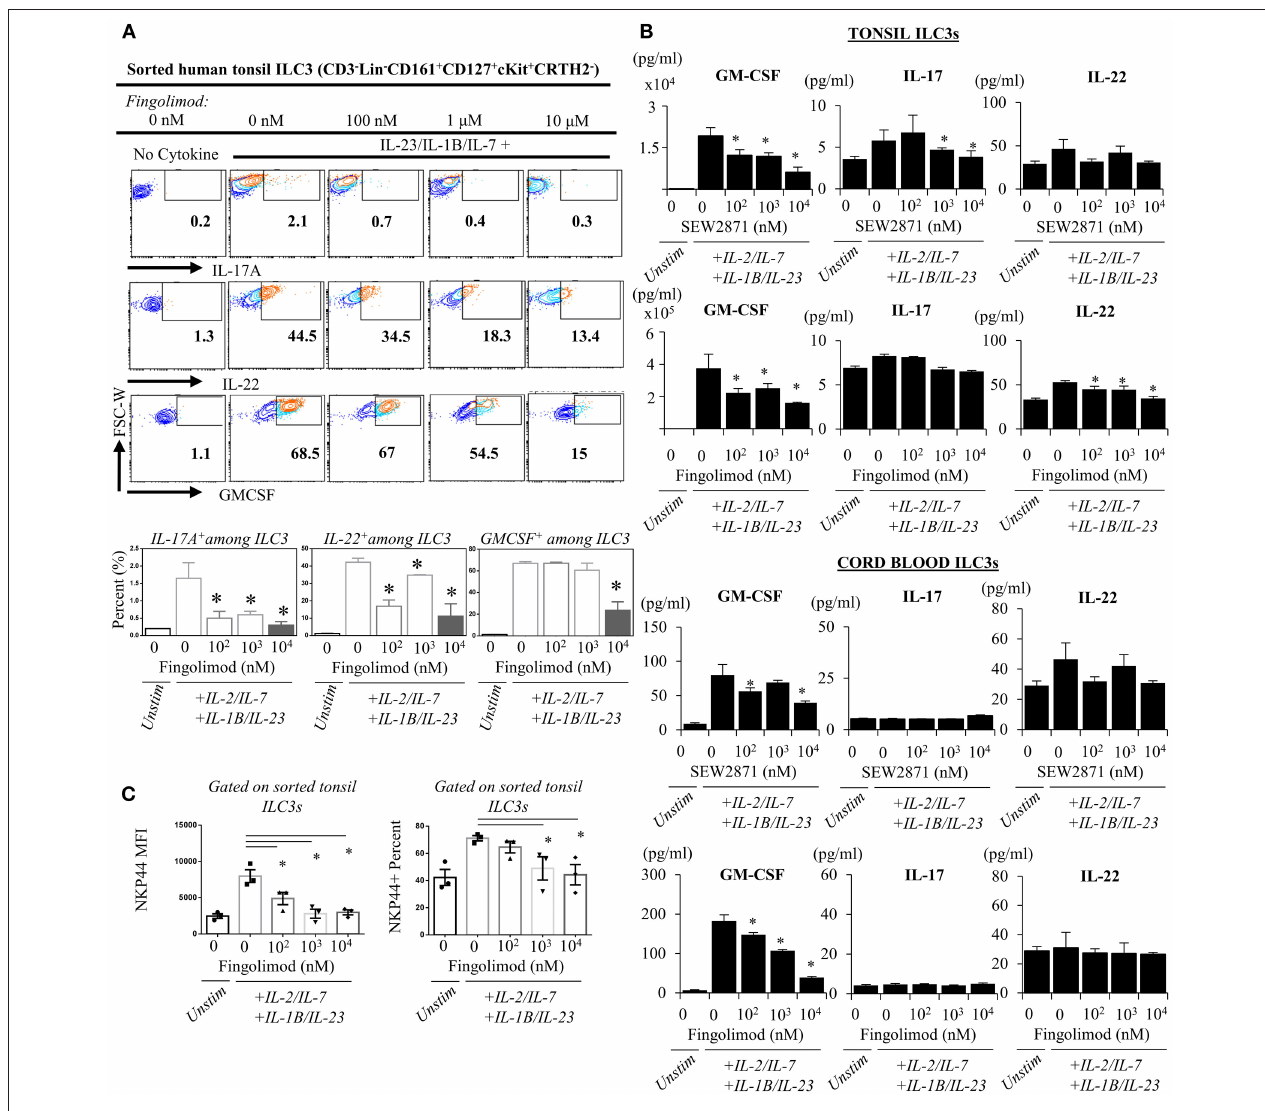
FIGURE 4 | Ex vivo exposure of human ILC3s to S1P analogs inhibits production of ILC3-associated cytokines. (A) Sorted ILC3s from tonsils (gated as Lin-CD3-CD161 + CD127 + ckit + CRTH2-) were cultured in complete medium at increasing doses of FTY720 and activated with IL-2, IL-23, IL-7, and IL-1B (20ng/ml each) for 2–3 days, and PMA (50ng/ml) /Inonomycin (1 µ g/ml) stimulated for 4h at 37 ◦ C for intracellular staining of indicated cytokines, representative flow plots (left) and quantified bar graphs for percentages of cells producing the indicated cytokines (right). (B) ELISA was performed from supernatants of “A” and SEW2871 exposed tonsil-derived (top panel) cord blood-derived (bottom panel) ILC3 cultures for ILC3-asssociated cytokines cord-derived ILC3s. (C) NKP44 surface expression by ILC3s were examined via flow cytometry, percent and mean fluorescence intensity (MFI) was quantified after culture with FTY720 for 3 days. *Indicates p < 0.05. The experiments were performed with triplicates and repeated for 3